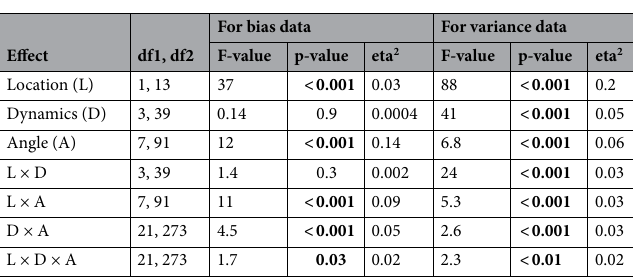
Table 2. Results from the ANOVAs of Experiment